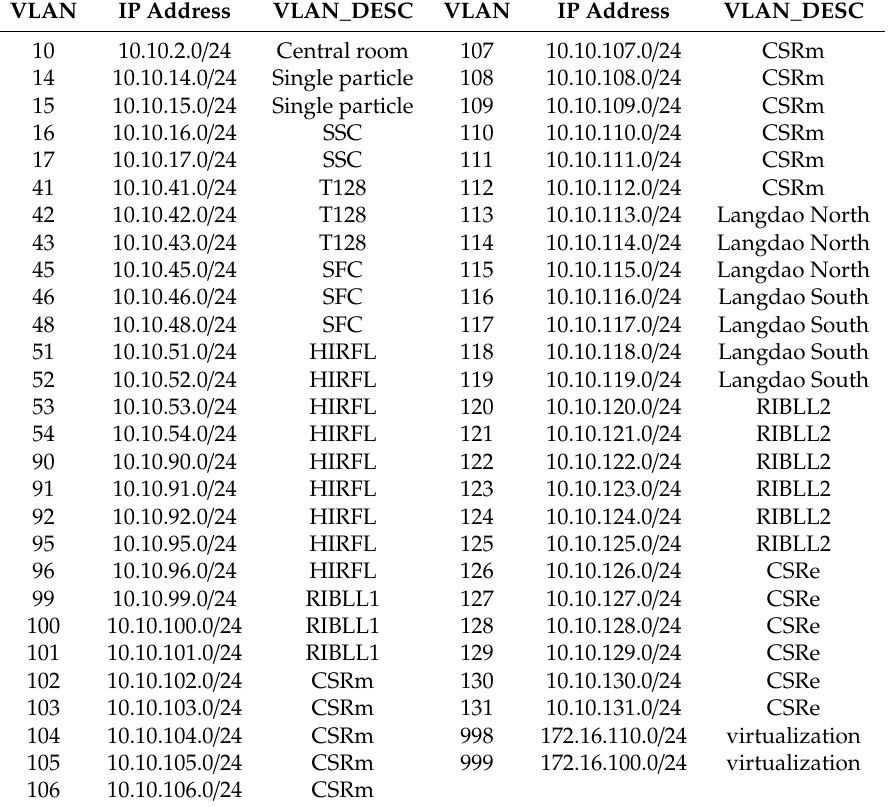
Table 1. All IP addresses used in port